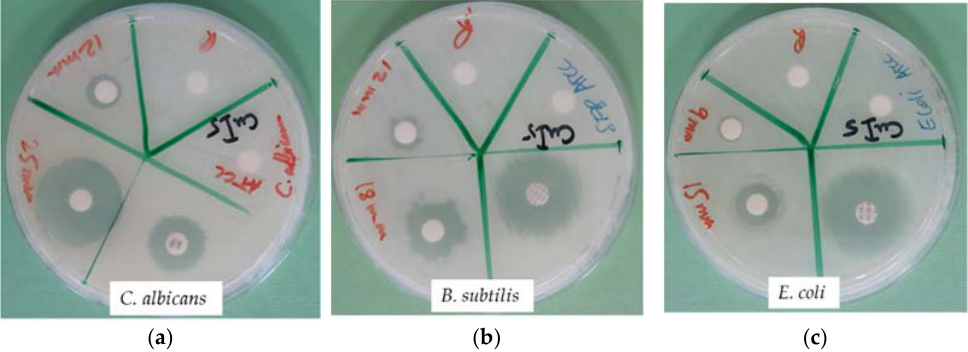
Figure 11. The disc diffusion (DD) studies with positive controls (antibiotic). From left to right: Title compound against ( a ) C. albicans WDCM 00054; ( b ) B. subtilis WDCM 00003; and ( c ) E. coli WDCM 00013. Disc diffusion (DD) studies with the title compound reveal the highest antimicrobial action with a ZOI of 25 mm against the fungus C. albicans WDCM 00054 and the Gram-positive S. pneumoniae ATCC 49619, followed by Gram-negative P. mirabilis ATCC 29906 (ZOI = 20 mm), and B. subtilis WDCM 00003 (ZOI = 18 mm) (Table 6, Figure 11). K. pneumoniae WDCM 00097 and E. faecalis ATCC 29212 are similarly susceptible with a ZOI = 16 mm, closely followed by the Gram-negative E. coli WDCM 00013 with a ZOI = 15 mm, and finally, S. pneumoniae ATCC 49619 (ZOI = 18) (Table 6). The microbicidal action decreases in the order S. pyogenes ATCC (Table 6). S. pneumoniae ATCC 49619 and P. mirabilis ATCC 29906 show higher susceptibility in DD studies than in AW (Table 6). They are also more susceptible to the title compound compared to [Cu(12-crown-4) 5 (H 2 O) 6 ]I 6 x 2I 2 [50]. P. aeruginosa WDCM 00026 (ZOI = 12)